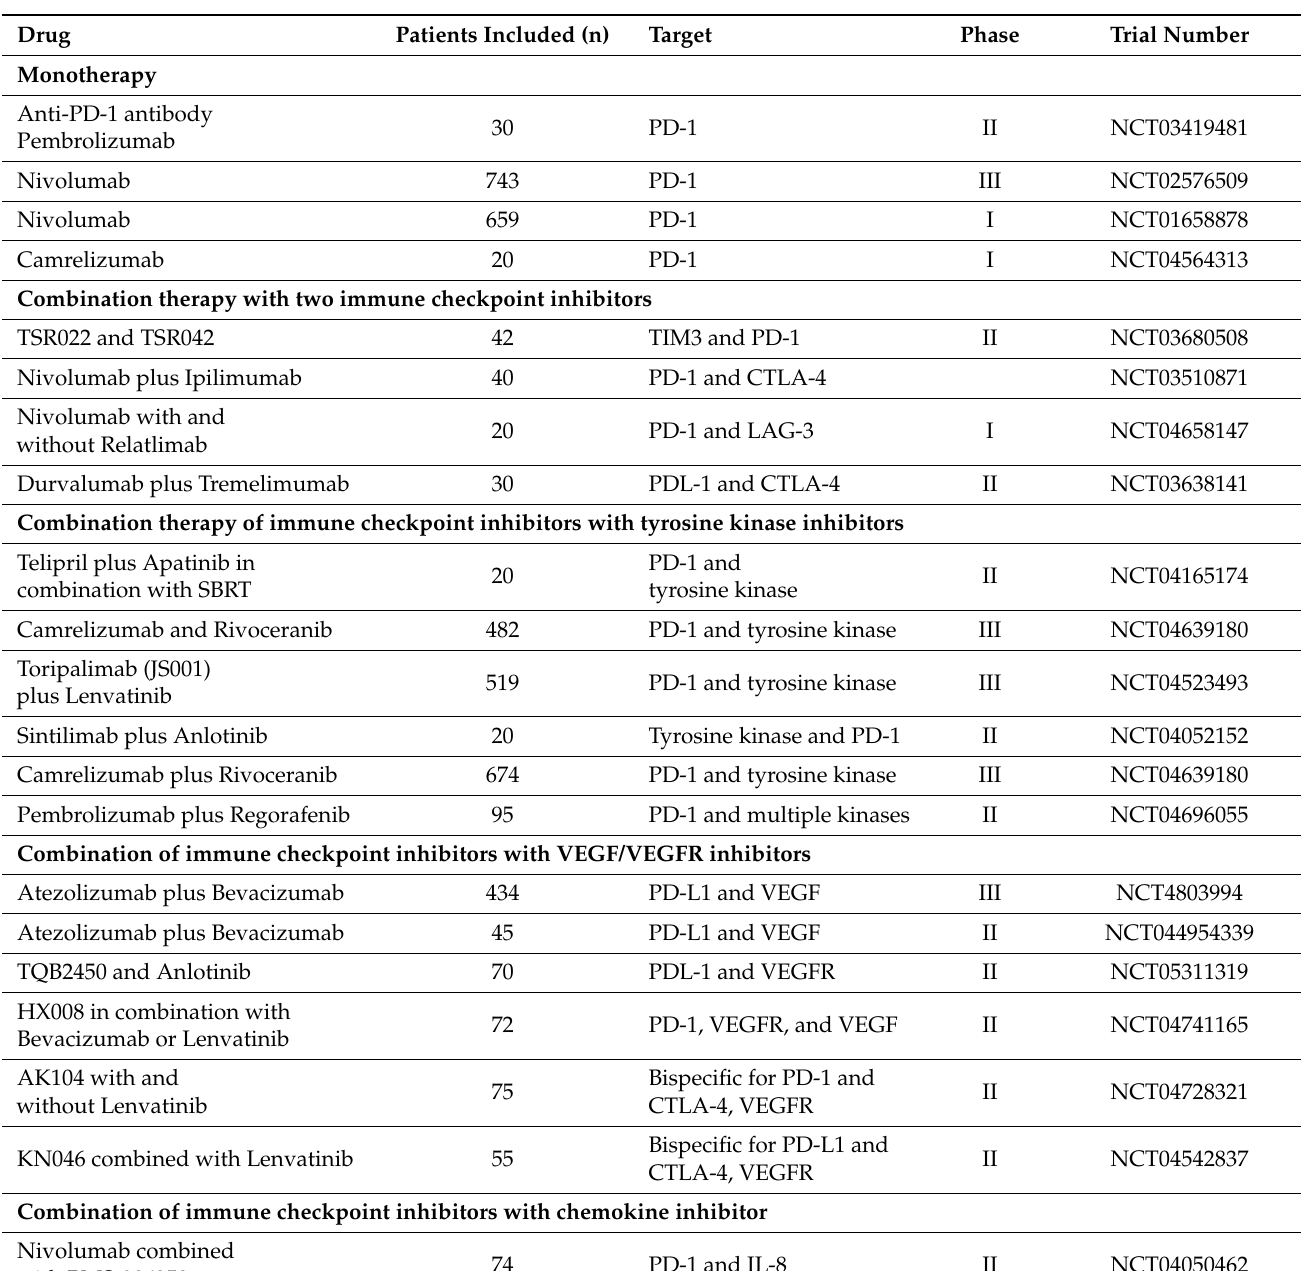
Table 2. Mono and combination therapy of checkpoint inhibitors for HCC